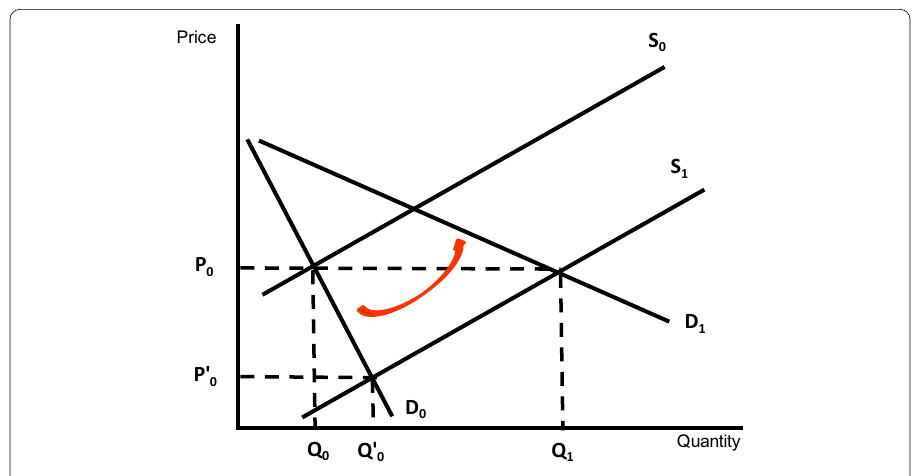
Fig. 7 Need of a multidisciplinary approach to expand the consumption of